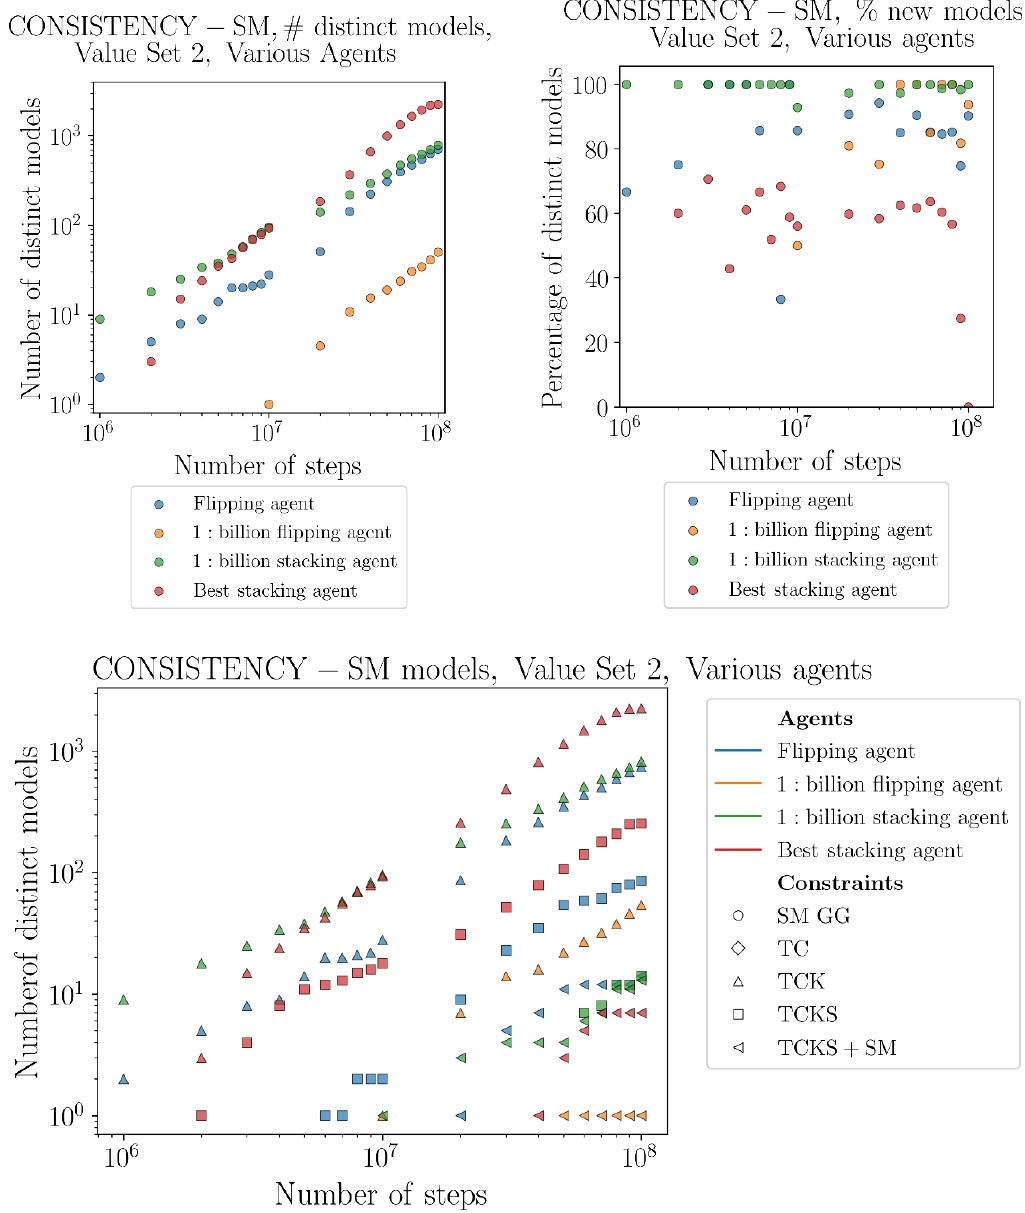
Figure 10 . Results for the (cid:13)ipping and the two one-in-a-billion agents, with the best stacking agent included for comparison. We show the overall number of models (top left), the rate of (cid:12)nding new models (top right), and the properties of the found models (bottom) for reward function CONSISTENCY-SM and hyperparameter (cid:13) = 0 :